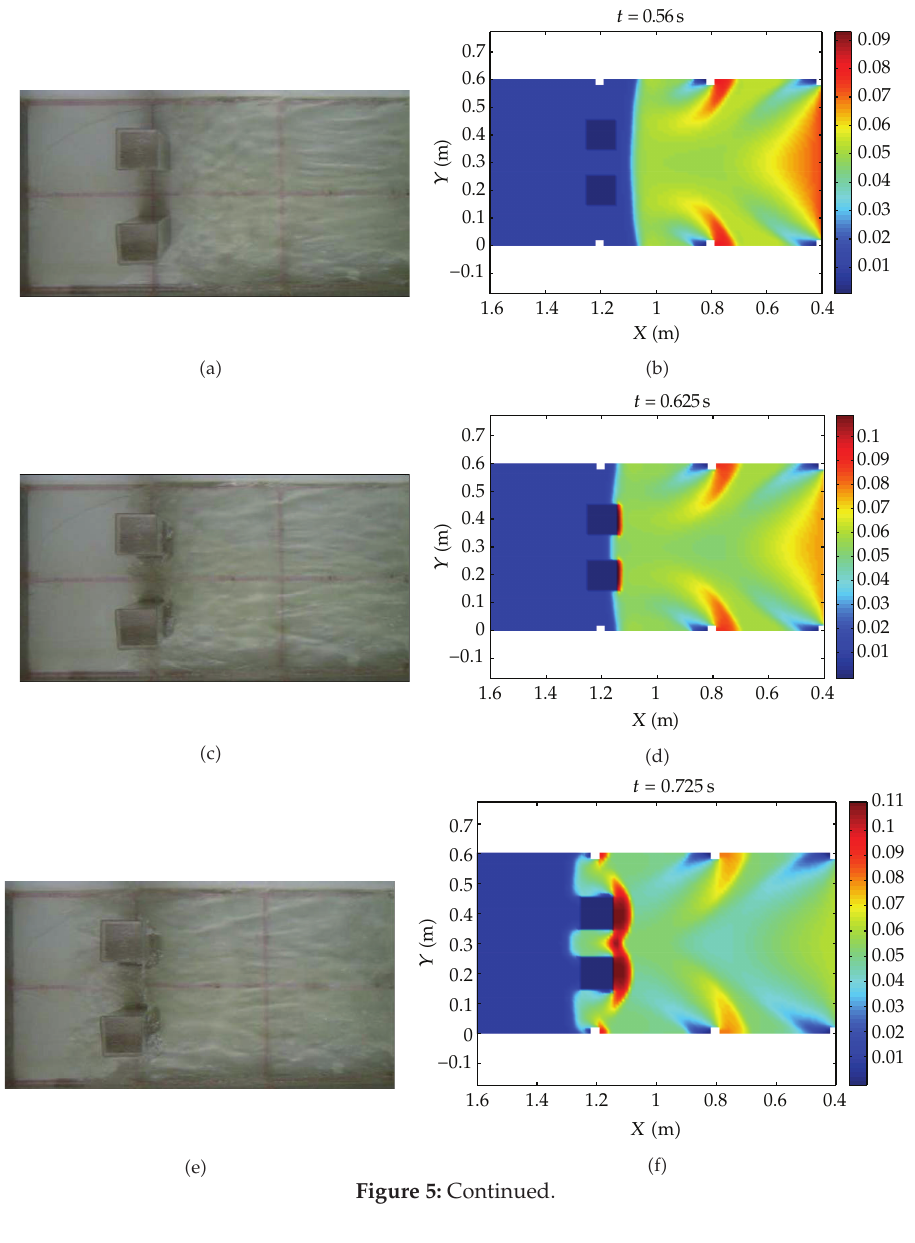
Figure 4: Initial conditions of experiment and 2D numerical simulation. The gate is located at x (cid:9) 0 . 4m, the dam-break modeling initial water depth 0.15m, the downstream water depth 0.01m, and 2 square columns (cid:5) 0.1m × 0.1m × 0.3m (cid:6) paralleled placed at x (cid:9) 1 . 2m with the distance